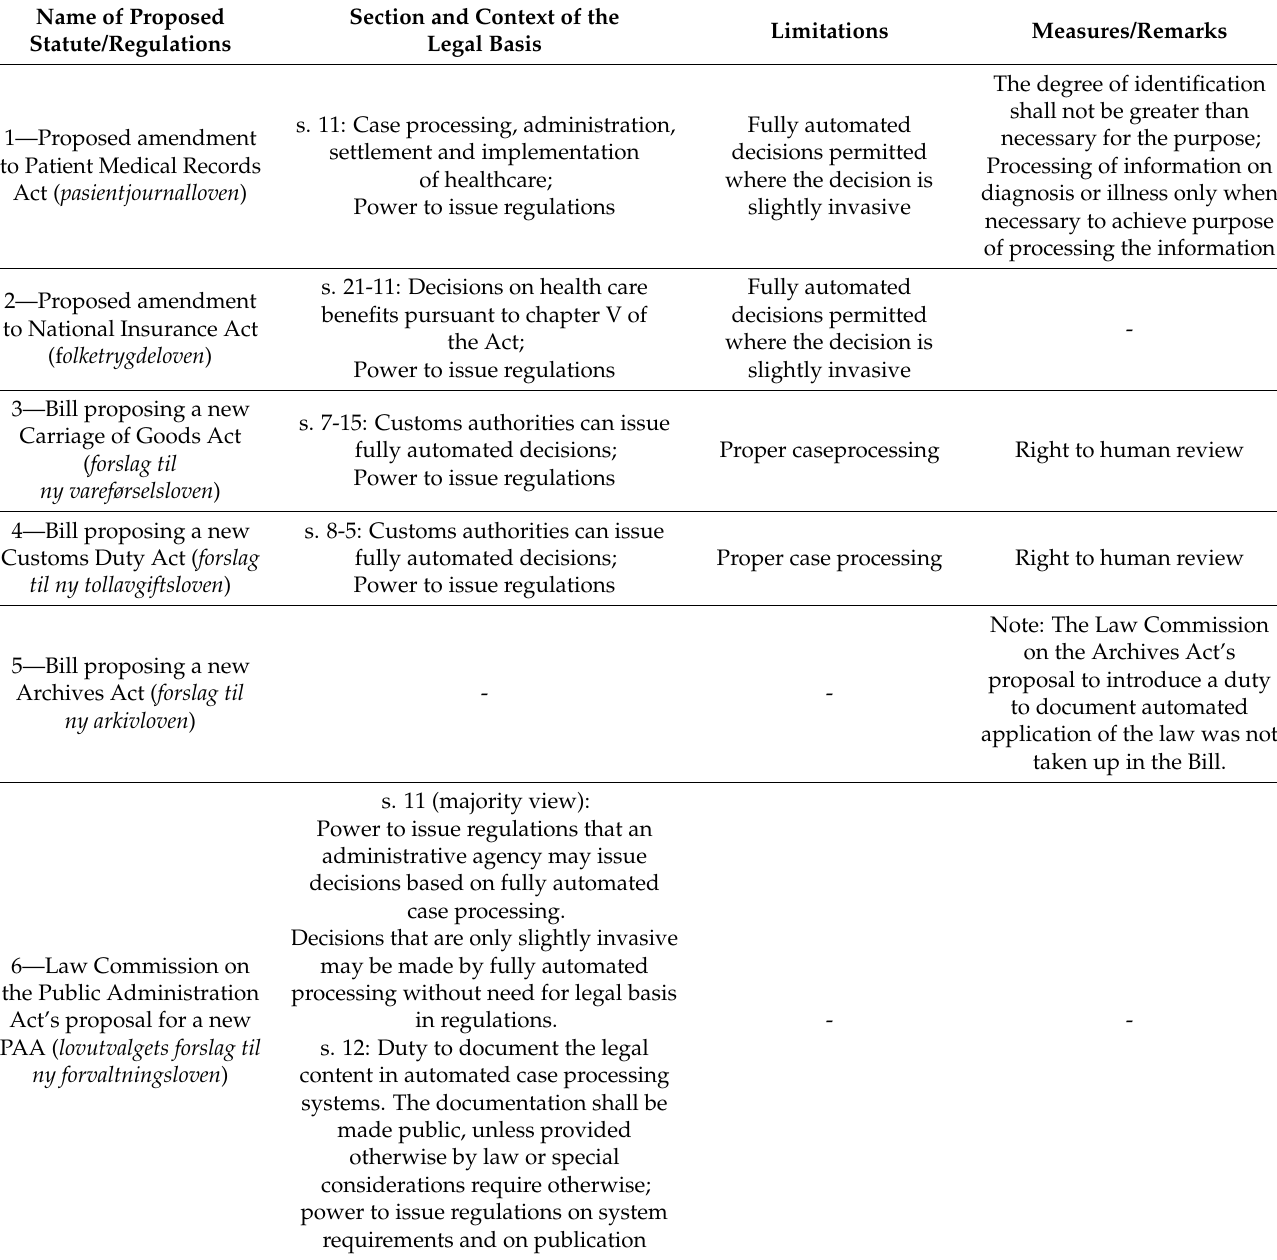
Table 3. Substantive proposal for amendments to